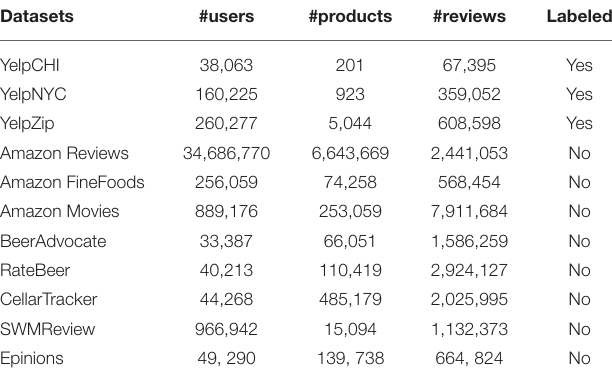
TABLE 4 | The statistics of fake review